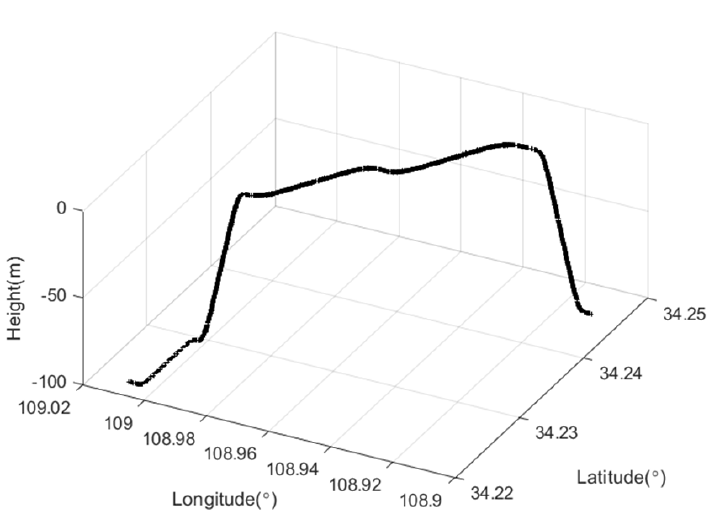
Figure 6. Curve of moving trajectory.